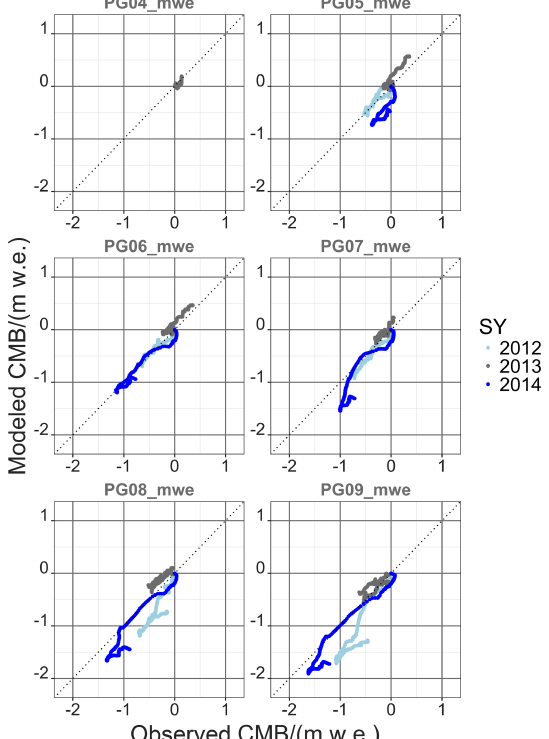
Figure 10. Cumulative mass balance (CMB) from simulations with the glacier melt model (modelled CMB) and observation (observed CMB) on the Warszawa Icefield (transect ID PG0 x ) for calibration purposes. Year numbers give the year of start of the glaciological mass balance year. It encompasses the glaciological years 2012/13 to